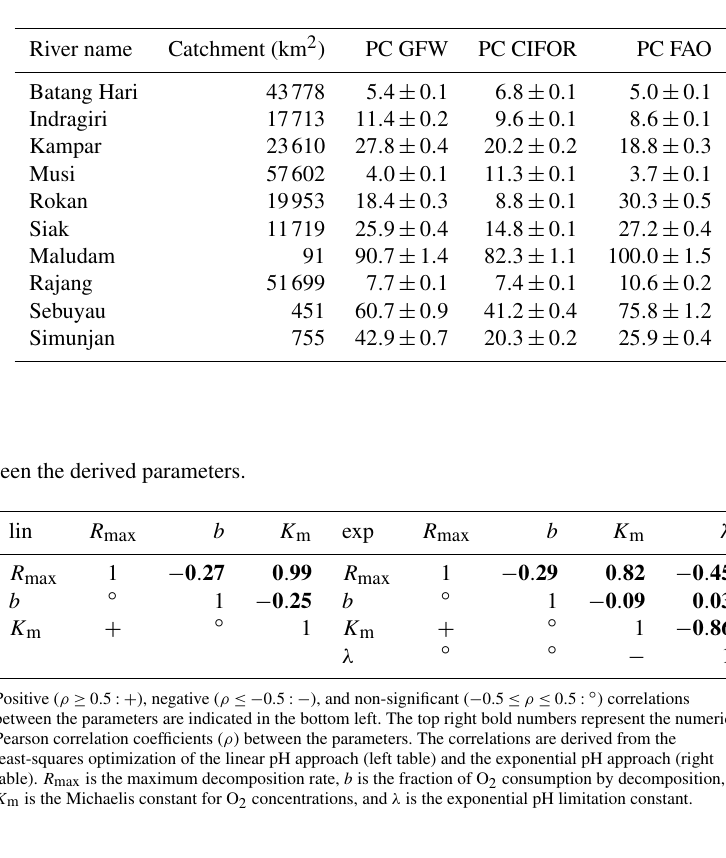
Table C2. Results for peat coverage (PC) in the different catchments using the three different data products.